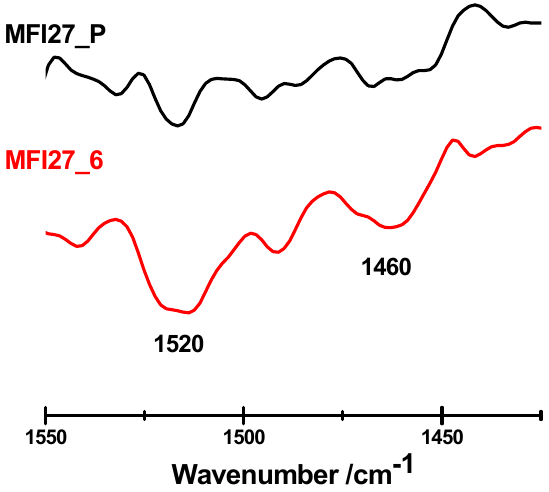
Figure 7. FTIR spectra of as-received MFI27_P and MFI27_6 zeolite samples.